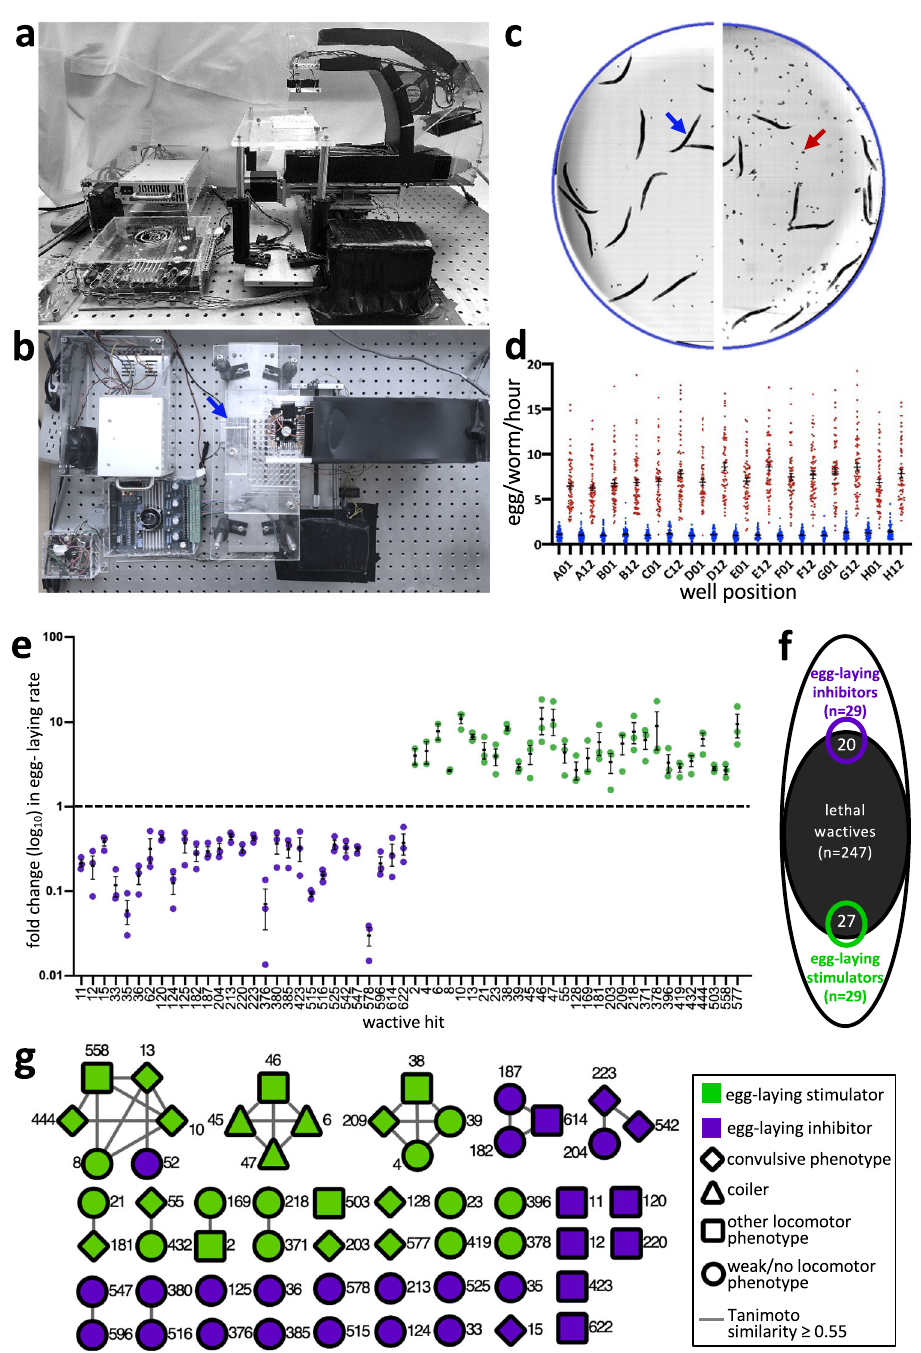
Fig. 1 The identi fi cation of 58 small molecules that modulate the C. elegans nervous system. a , b Two perspectives of the ‘ 2020 Imager ’ showing one 96-well plate in the imager holder (arrow). c Representative half-well images of vehicle controls in the basal (M9-only) background (left) and the ‘ stimulatory cocktail ’ of 12.3 mM serotonin creatine sulfate and 7.7 mM nicotine (right) after 1 h. A blue arrow points to an adult hermaphrodite and a red arrow points to a pair of embryos. d The distribution of counts of eggs/worm/hour for the basal background (blue) and the stimulatory background (red) from the indicated well-coordinates over 22 experimental replicates (96-well plates). The mean and SEM is shown, n = 66 biologically independent samples with ~20 animals per data point. e A screen of the worm active (wactive) library yields 29 inhibitors (purple) and 29 stimulators (green) of the C. elegans egg-laying rate. Mean Egl rate and SEM is shown from n = 3 independent biological replicates, conducted in technical triplicate with ~20 animals per technical replicate. f Venn diagram showing the overlap of the wactive molecules that are lethal (at 60 µ M) with those that modulate egg-laying among the 486 molecules assayed in both assays. g A structure similarity network of the 58 egg-laying modulators. Each node represents a numbered wactive molecule. Connecting lines indicate shared structural similarity. Additional information is provided in Fig. 2. Primary data for this fi gure can be found in Supplementary Data